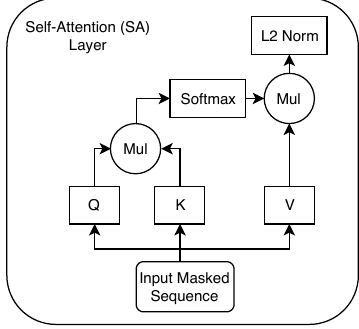
Figure 2. Self-attention layer empolyed in the SABA architecture.